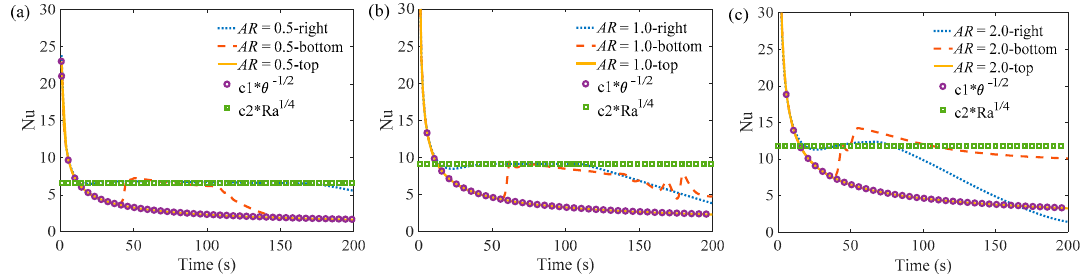
Figure 8. The evolutional liquid fraction in three enclosures by heating the different sides. ( a ) AR = 0.5; ( b ) AR = 1.0; ( c ) AR = 2.0.